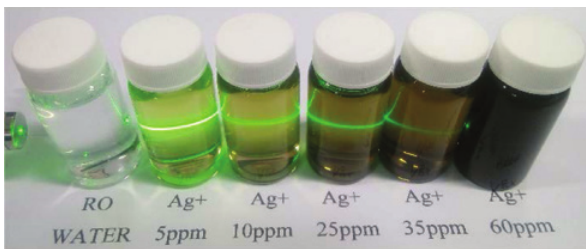
Figure 1: The color of the nano Ag particle suspension changed from yellow to dark